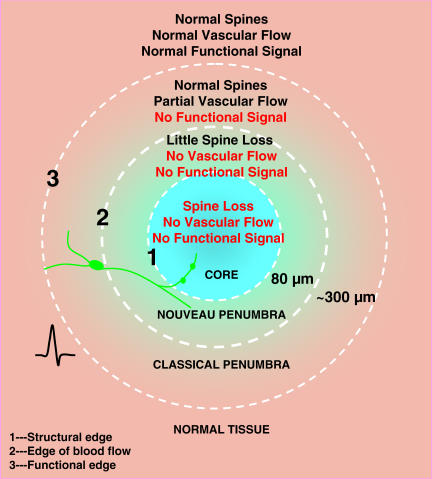
Summary Diagram Showing the Relationship between the Ischemic Core and Synaptic Structure/FunctionThe stroke core in colored blue to indicate poor oxygenation; note the distances shown are not to scale. We find no vascular flow within the core (for small vessels of capillary size), a loss of dendritic structure and spines, and no functional signals (IOS imaging). The first dashed line indicates a region (outside the core) where intact dendrite structure begins to be seen (denoted “1,” termed the structural border). Intact dendritic structure can be found on average ~80 μm from the beginning of blood flow (on the ischemic side of the vascular flow border, vascular flow border denoted “2”). This region, containing intact structure but no vascular flow is termed the Nouveau Penumbra, and represents a newly described region that is ischemic, but has potentially salvageable structure. We have colored the Nouveau Penumbra light blue since it may exhibit partial oxygenation derived from diffusion from areas with vascular flow. Outside of the Nouveau Penumbra is a zone between the beginning of vascular flow and somatosensory function (the functional border is denoted “3”). This region is the Classical Penumbra, which has been previously described, but not resolved at this level. The Classical Penumbra region has partial blood flow and oxygenation, but is nonfunctional. Normal fully perfused tissue lies outside the Classical Penumbra.